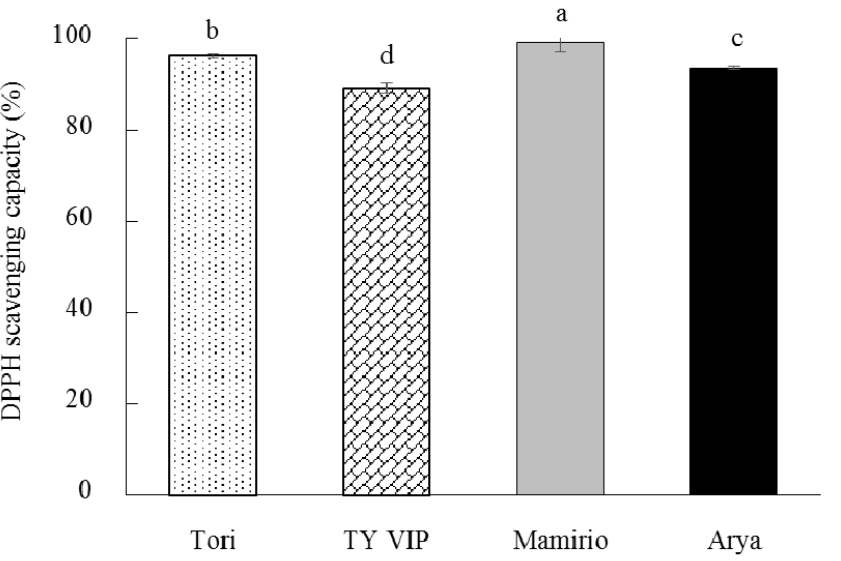
Figure 5. Antioxidant activity of ‘Tori’, ‘TY VIP’, ‘Mamirio’, and ‘Arya’ tomato cultivars at commercial pink ripening stage. The bars with different letters indicate a significant difference ( p < 0.05) between cultivars. The vertical bars represent the standard error of the means ( n = 5).